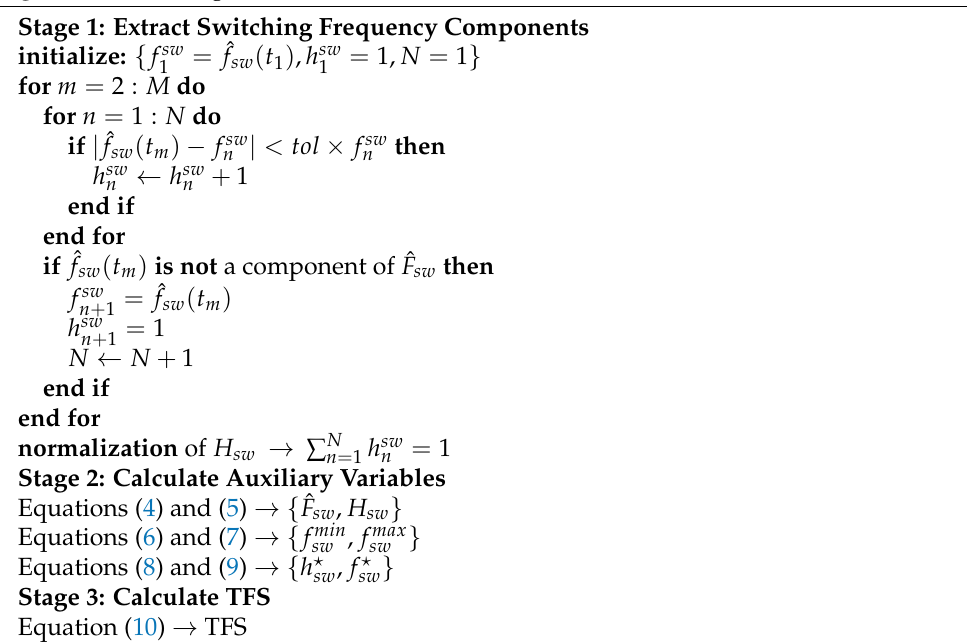
Algorithm 2 TFS Algorithm